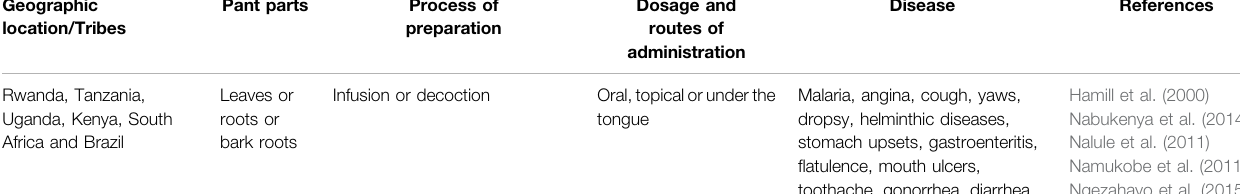
TABLE 1 | Common traditional uses of T. riparia throughout different parts of the world. Geographic